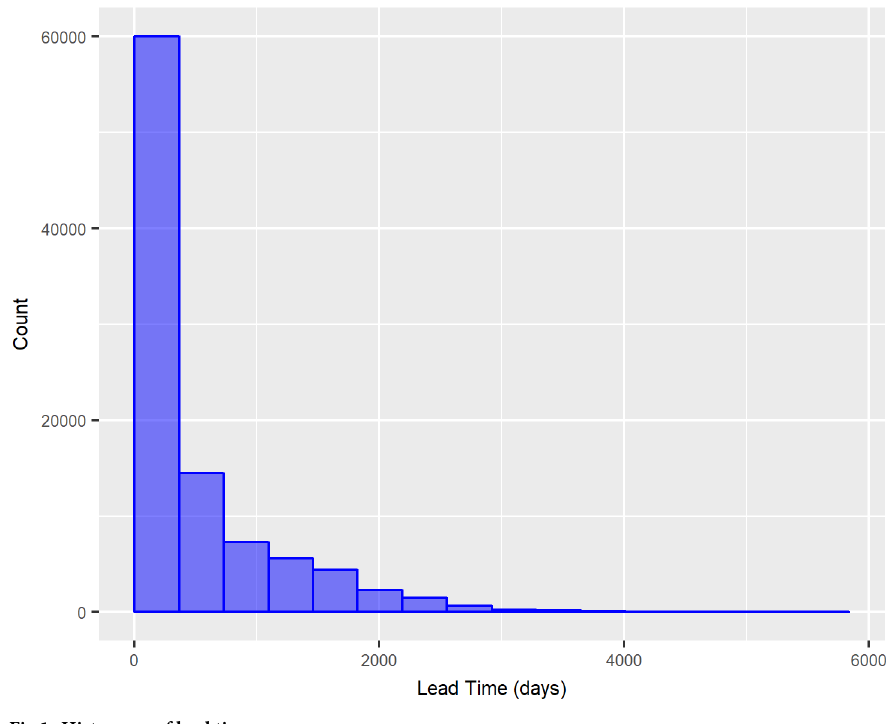
Fig 1. Histogram of lead